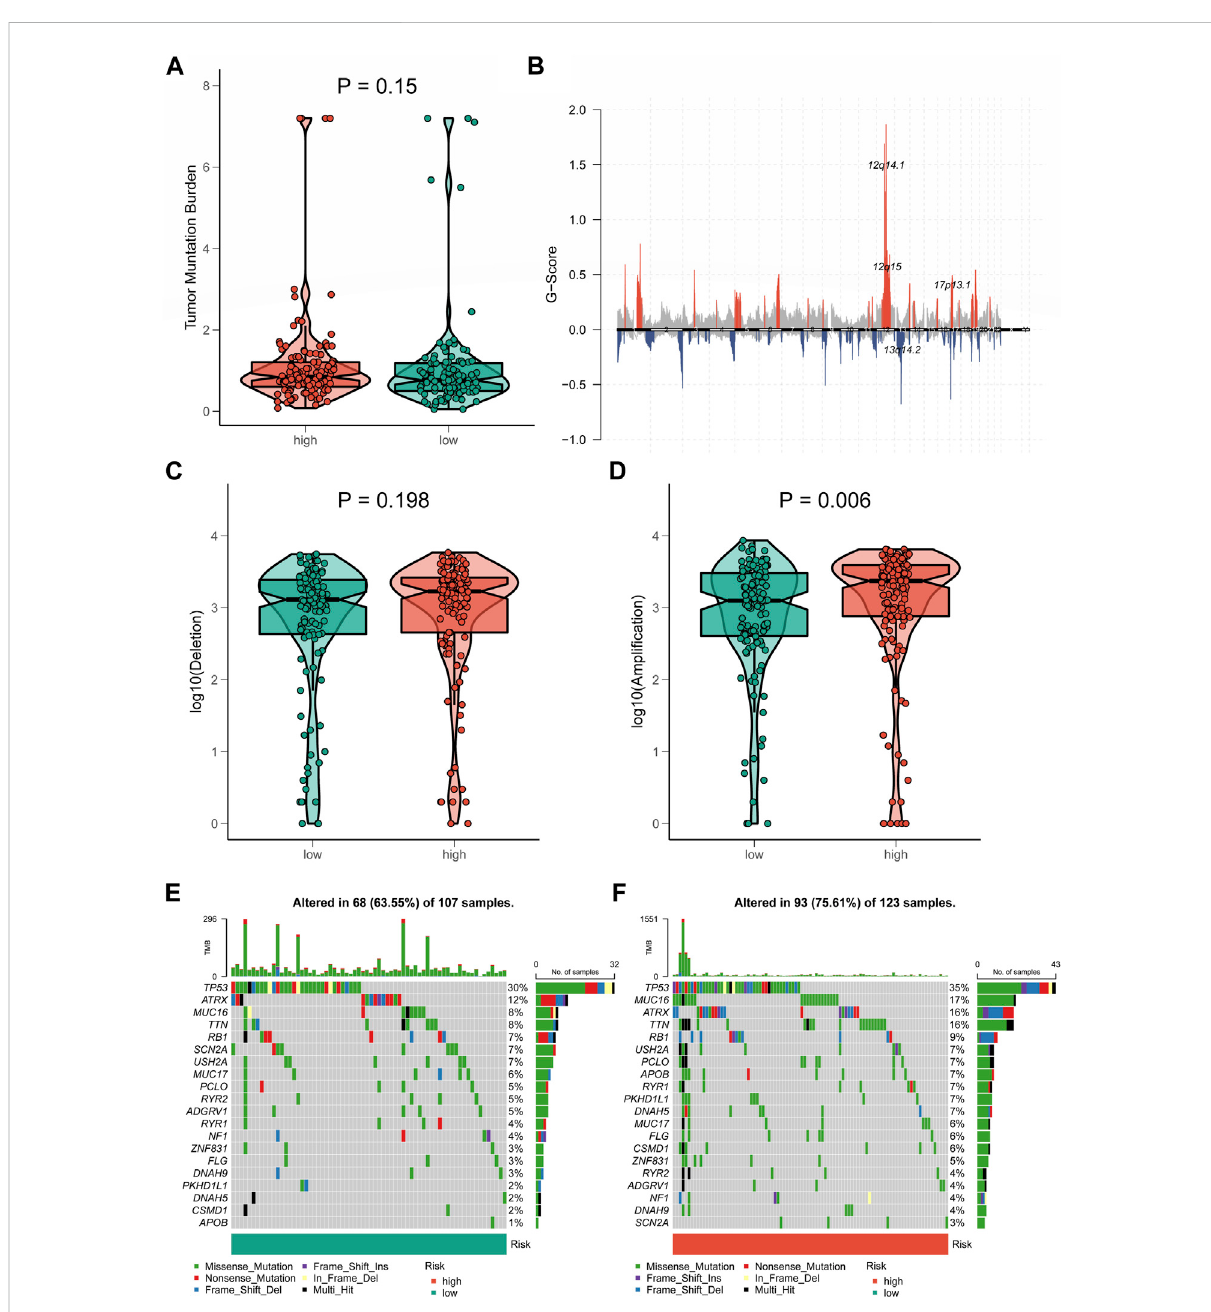
FIGURE 9 Tumor mutation status among different risk groups. (A) TMB in the high- and low-CRLncSig groups. (B) The genome-wide gene CNV of STS. (C,D) The difference in CNV loss and gain between the distinct risk groups. (E,F) The differences in mutations between distinct risk groups (the top 20 mutated